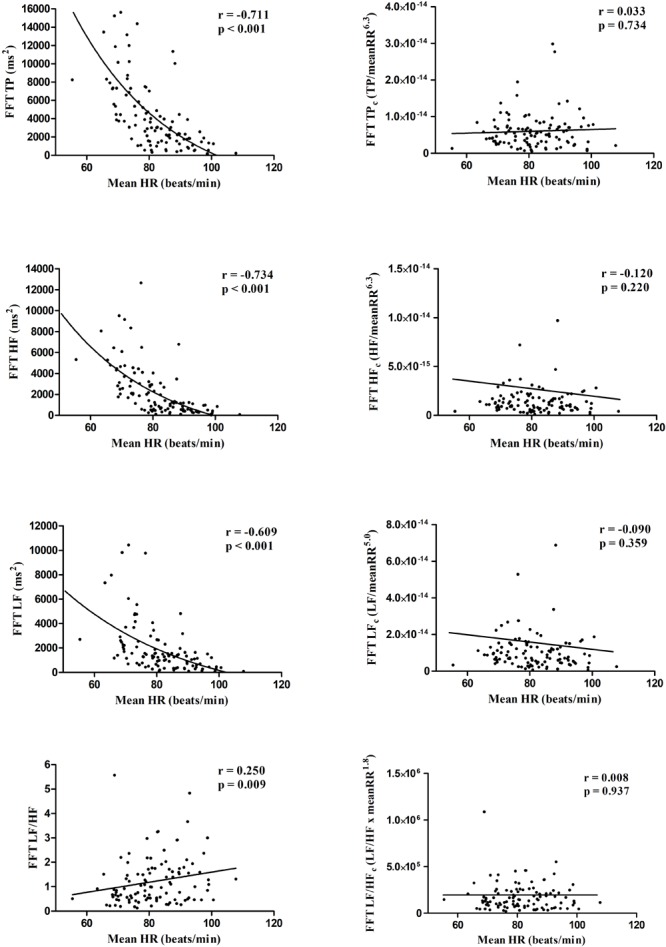
Scatter plots showing the Spearman correlations of frequency domain standard (left panels) and corrected (right panels) HRV parameters with mean heart rate.